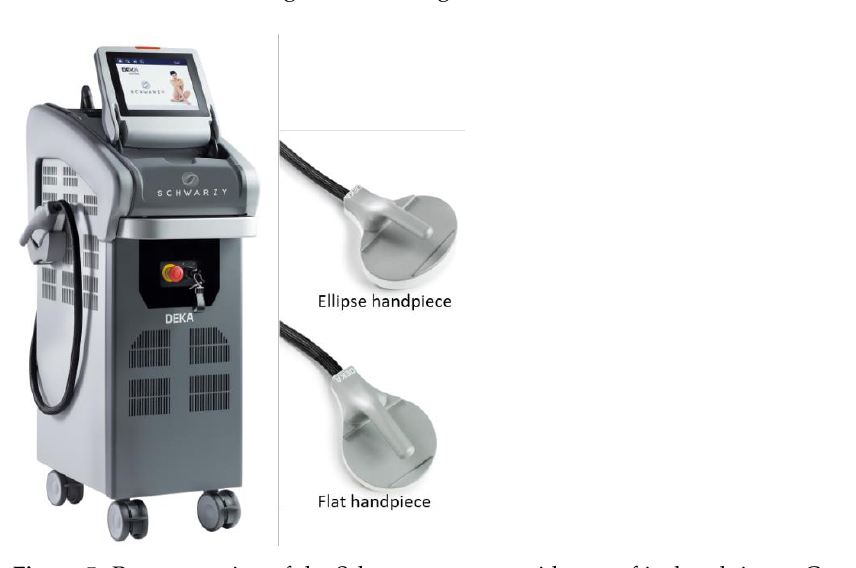
Figure 5. Representation of the Schwarzy system with two of its handpieces. Courtesy of DEKA MELA company, Calenzano, Italy.